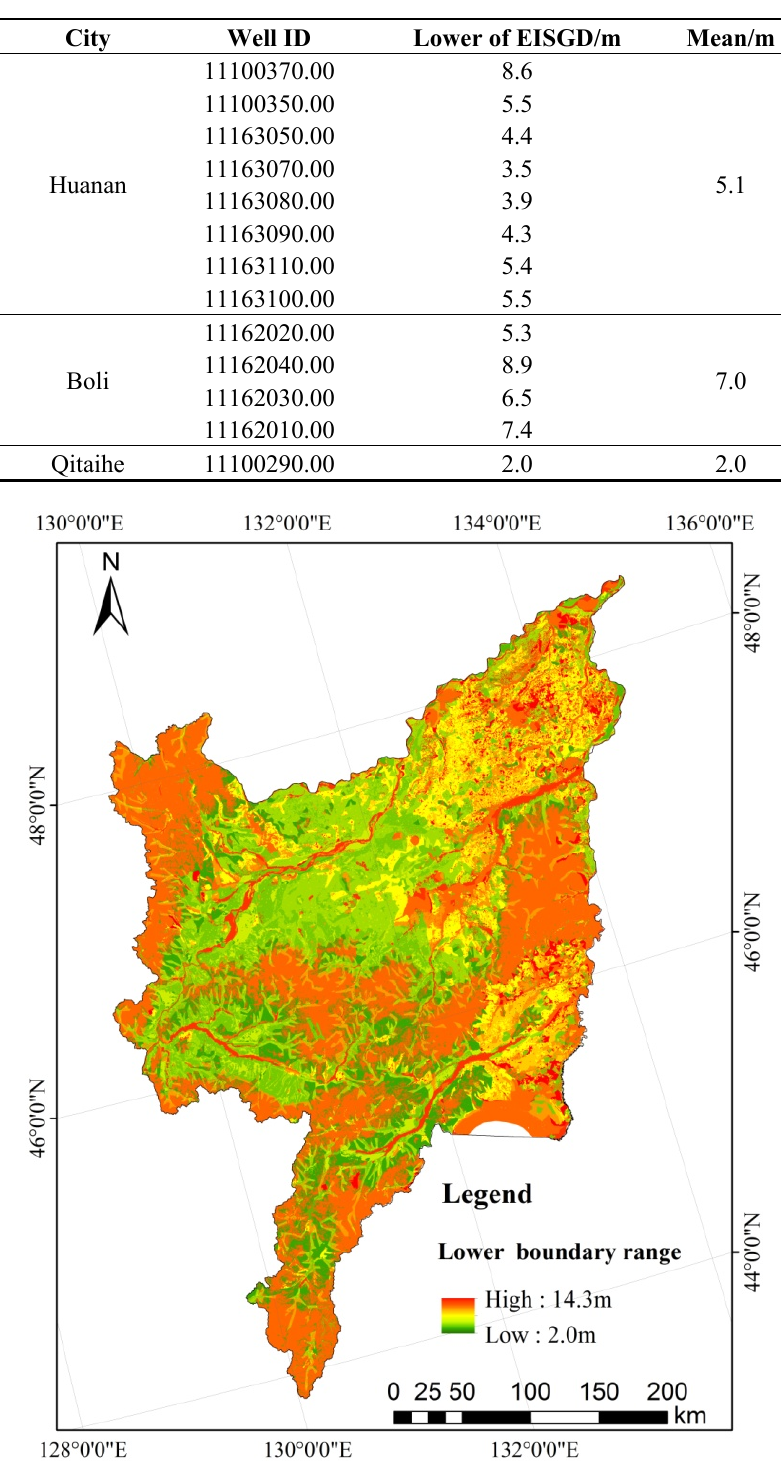
Figure 11. Spatial distribution of the lower boundary of ecologically ideal shallow groundwater depth (EISGD) in the Sanjiang Plain, northeast China. Five major vegetation types in the region were identified a lower EISGD boundary ranging from 2.0 to 14.3